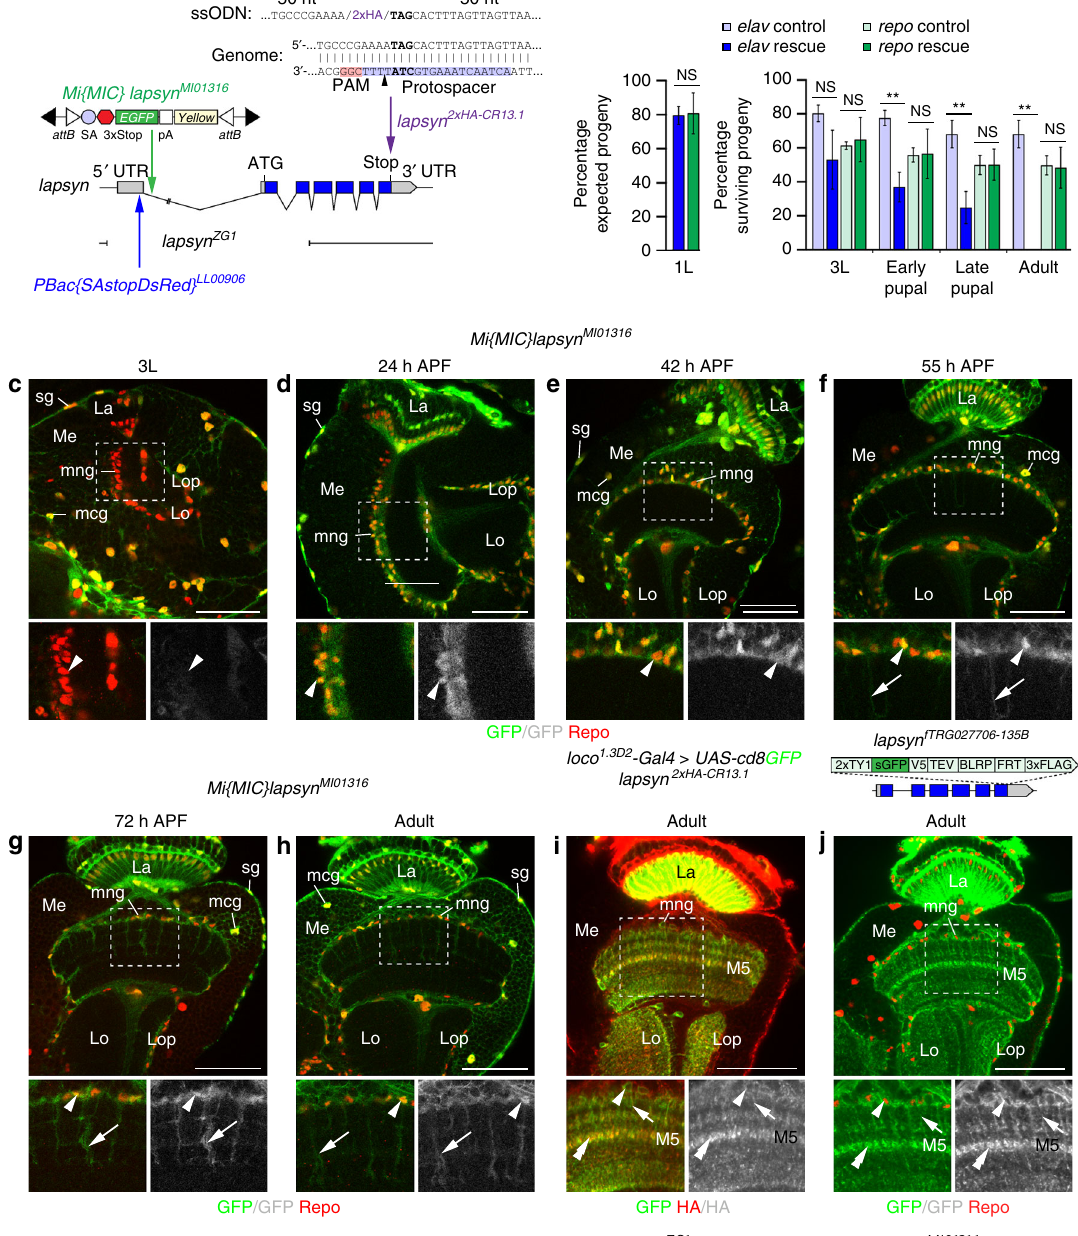
Fig. 4 lapsyn is expressed in glia. a The schematic shows the lapsyn genomic locus, the lapsyn ZG1 deletion, and Mi{MIC}lapsyn MI01316 and PBac{SAstopDsRed} LL00906 insertions. pA polyadenylation site, SA splicing acceptor site. To generate lapsyn 2xHA-CR13.1 , two C-terminal HA epitope tags were inserted into the endogenous locus following a Cas9-induced DSB and HDR with a single-stranded oligo donor nucleotide ( ssODN ) containing fl anking 50-nt homology arms. b For whole animal rescue experiments of lapsyn ZG1 embryonic lethality, UAS-lapsyn was expressed in neurons ( elav C155 -Gal4 , blue bars , 224 recovered fi rst instar (1L) larvae of 1210 embryos) or in glia ( repo-Gal4 , green bars , 529 recovered 1L larvae of 2380 embryos). GFP-negative rescue fl ies were compared to controls carrying CyO Dfd-YFP balancer chromosomes, corresponding to all other surviving progeny (heterozygous, or heterozygous and overexpressing lapsyn , light blue and green bars ). Rescue of viability of 1L larvae ( left panel ) is shown as percentage of expected progeny. Rescue of viability of third instar (3L) larvae, early and late pupae and adults is shown as percentage of surviving progeny in “ rescue ” and “ control ” populations followed from the 1L stage onwards. Histograms show data points as means ± standard deviation error bars ( n = 3 independent experiments). Unpaired, two-tailed Student ’ s t- test assuming normality but unequal standard deviation (1L: P = 0.879; 3L: P = 0.1027, P = 0.6796; early pupae: P = 0.006, P = 0.9369; late pupae: P = 0.0042, P = 0.9921; adult: P = 0.0047, P = 0.8668). NS not signi fi cant, ** P < 0.01. c – h Mi{MIC}lapsyn MI01316 is inserted into the fi rst non-coding intron. In 3L larvae, Repo-positive ( red ) surface glia ( sg ) and medulla cortex glia (mcg), but not mng ( c ) are labeled with GFP. mng express GFP at 24, 42, 55, and 72 h APF, and in adults ( arrowheads ). mng processes are labeled from 55 h APF onwards ( f – h , arrows ). i , j lapsyn 2xHA-CR13.1 and the fosmid lapsyn fTRG027706 report abundant lapsyn protein localization in mng cell bodies ( arrowheads ), primary ( arrows ), and secondary processes ( double arrowheads ), particularly in layer M5, using anti-HA ( red ) and GFP labeling ( green ), respectively. La lamina, Lo lobula, Lop lobula plate, Me medulla. Panels c – j show single optical sections. For genotypes, sample numbers and additional statistical values, see Supplementary Tables 1 and